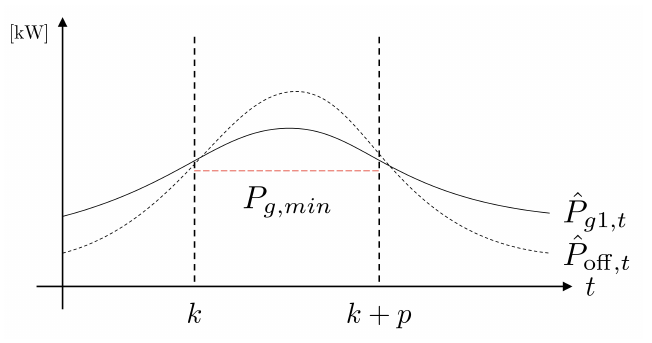
Figure 3. Offline ESS